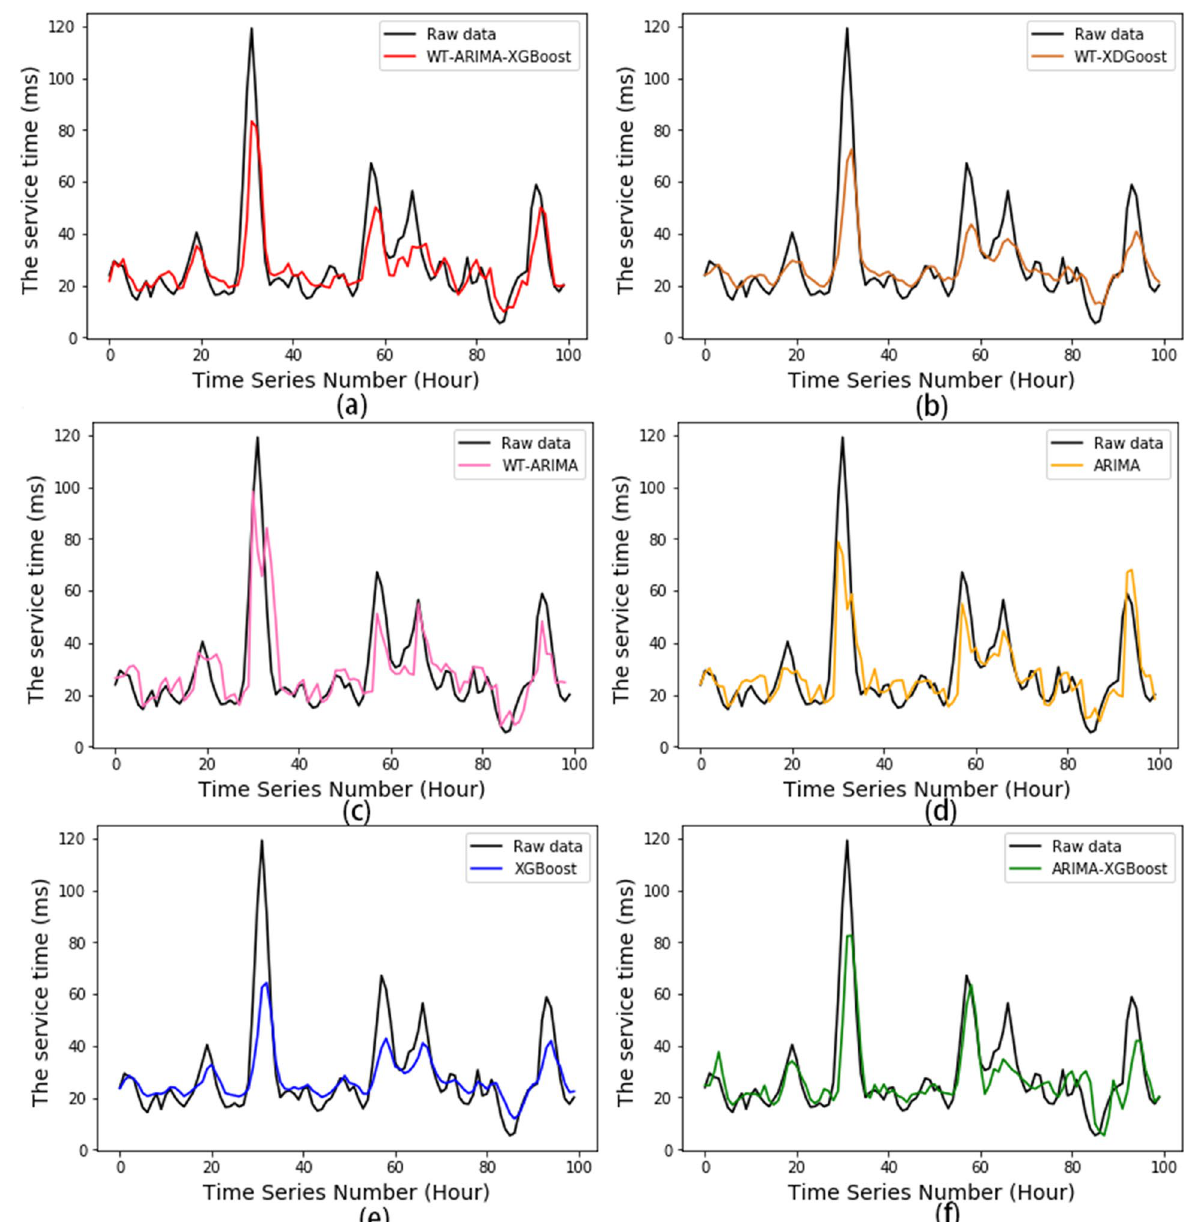
Fig. 6 Comparison of layer actions response time at three-step prediction using tested